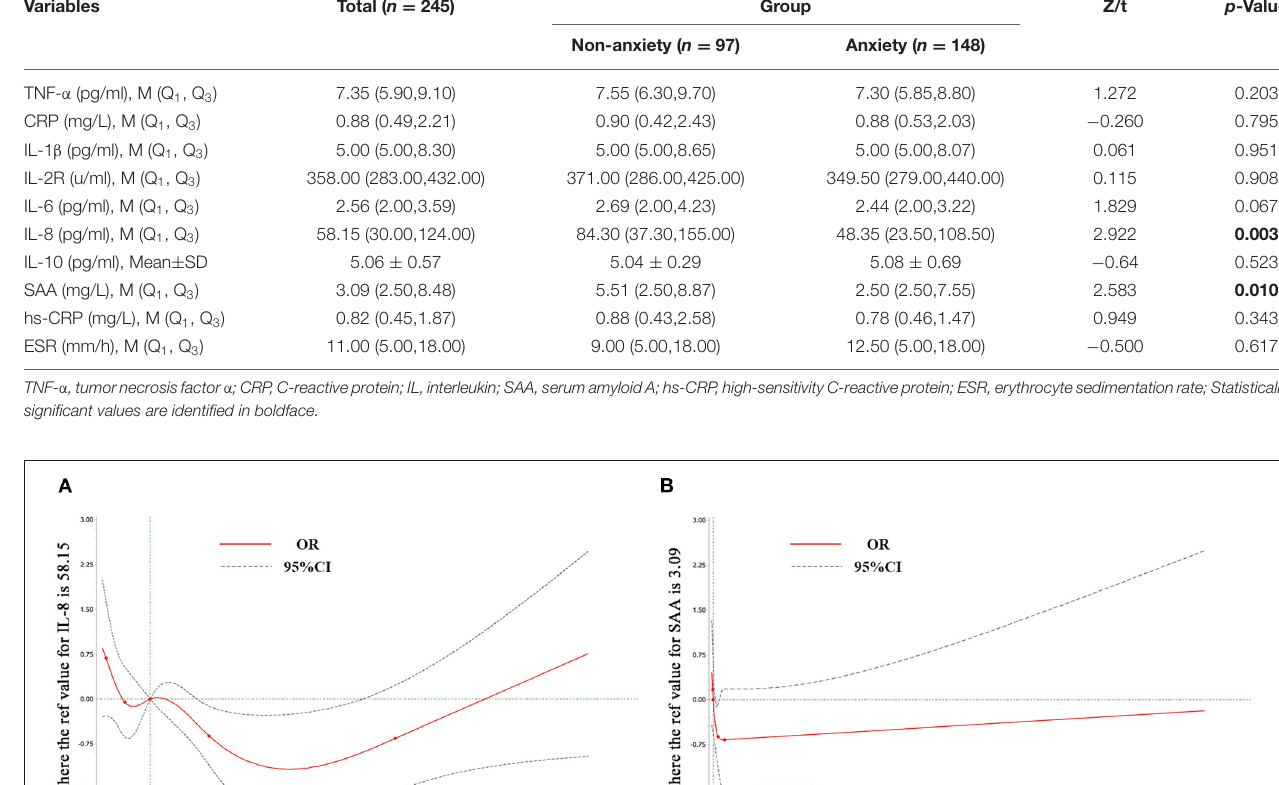
TABLE 2 | Comparisons of inflammatory markers between the two groups. Variables Total ( n = 245)